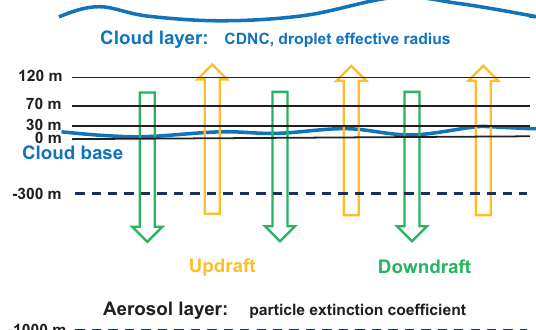
Figure 1. Sketch to illustrate our lidar-based approach to investi- gating aerosol–cloud interactions (ACI) in the case of pure liquid- water clouds (blue lines indicate cloud bottom and top). The particle extinction coefficient measured with the Raman lidar in the height range from 300 to 1000m below the lowest cloud base height (at 0m in the sketch) is used as aerosol proxy (dashed lines indicate base and top of the considered aerosol layer). From the dual-FOV Raman lidar observations we determine the cloud droplet number concentration (CDNC) and the effective radius for cloud layers from the lowest occurring cloud base to 30m above lowest cloud base, from 30 to 70m, and from 70 to 120m above the lowest cloud base. A collocated Doppler lidar measures the vertical wind component and thus periods with updraft and downdraft